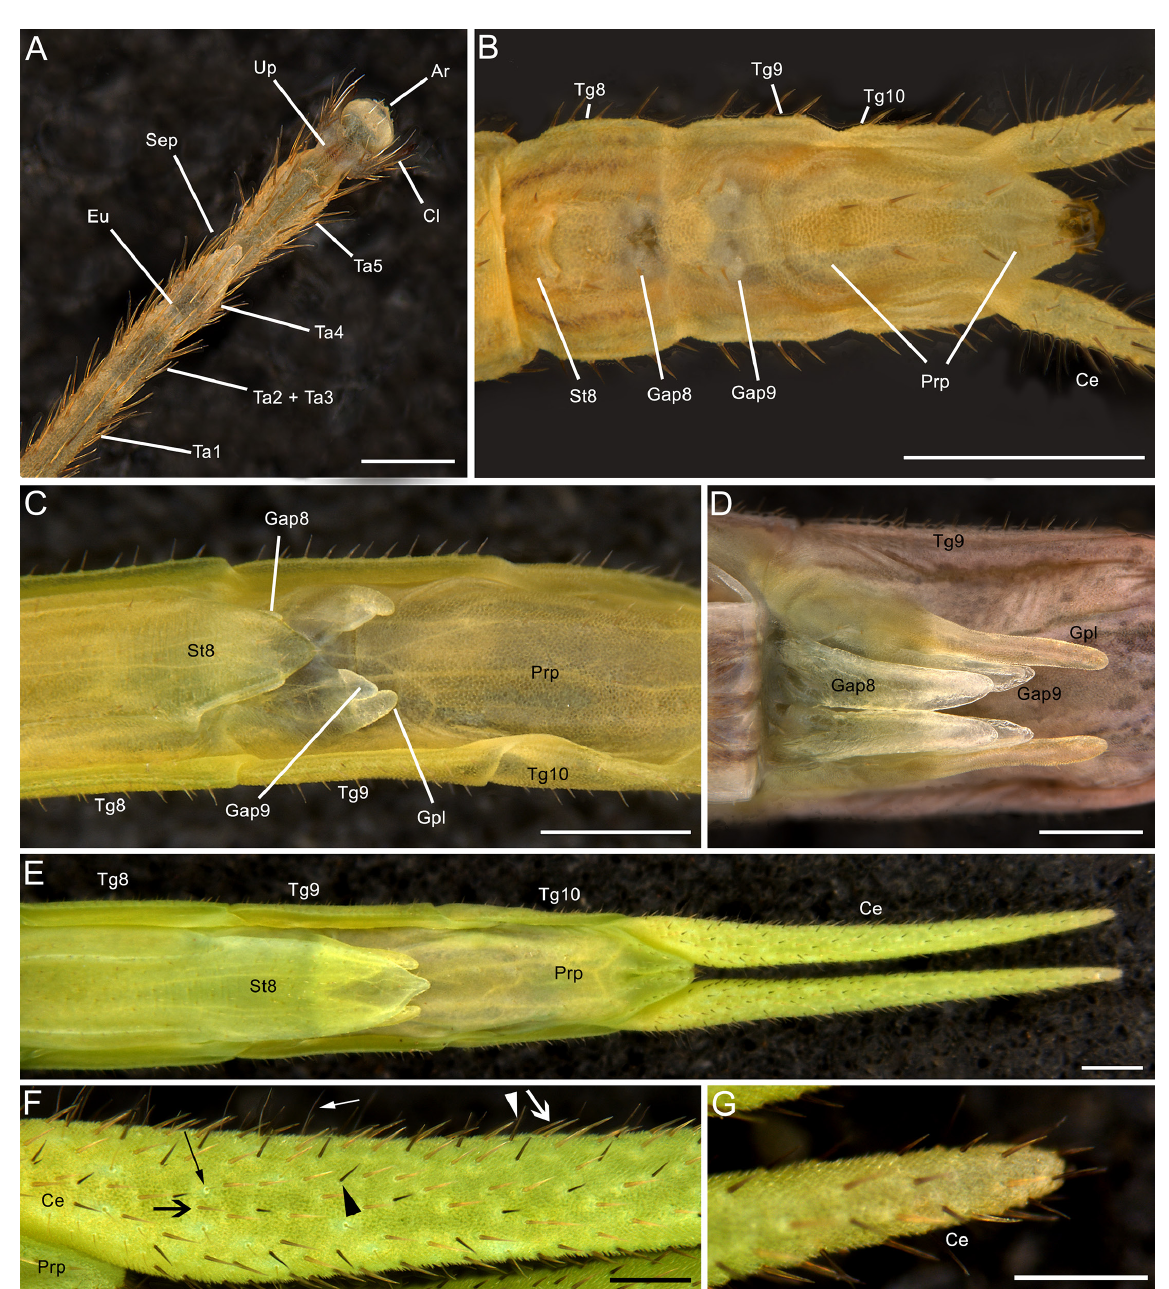
Fig. 11. Nymph morphology of Arumatia dubia (Caudell, 1904) gen. et comb. nov., female juveniles from stock from Ibaté, São Paulo, Brazil. A . Left fore tarsus of first instar, ventral view. B . Terminalia of first instar, ventral view. C . Terminalia of fourth instar, ventral view. D–E . Terminalia of fifth instar, ventral view, detail of external genitalia with tilted subgenital plate to permit visualization (D) and wider view of other individual (E). F–G . Detail of cercus of individual in E, showing sensory hairs (long arrow), stiff and straight setae (arrowhead) and inclined lighter setae (broad arrow) (F) and tip of cercus (G). Abbreviations: Ar = arolium; Ce = cercus; Cl = claw; Eu = euplantula; Gap = gonapophysis; Gpl = gonoplac; Prp = paraproct; Sep = setae of ventral patch; St = sternum; Ta = tarsomere; Tg = tergum; Up = unguitractor plate. Scale bars: A–E = 0.5 mm; F–G = 0.2